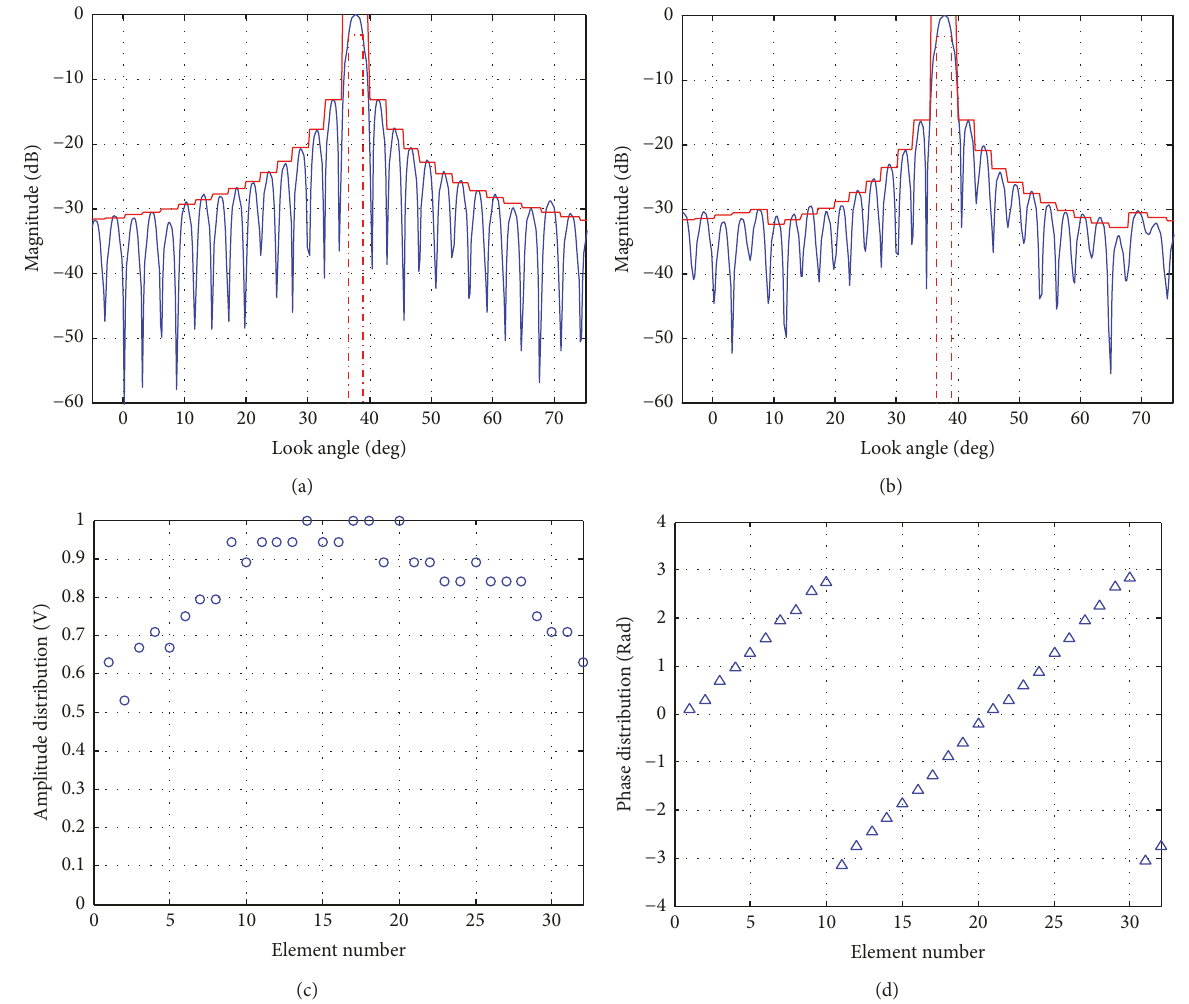
Figure 10: Antenna pattern synthesis results for beam number 10 of KOMPSAT-5. (a) Tx pattern (uniform). (b) Rx pattern (optimized). (c) Optimized amplitude. (d) Optimized phase.